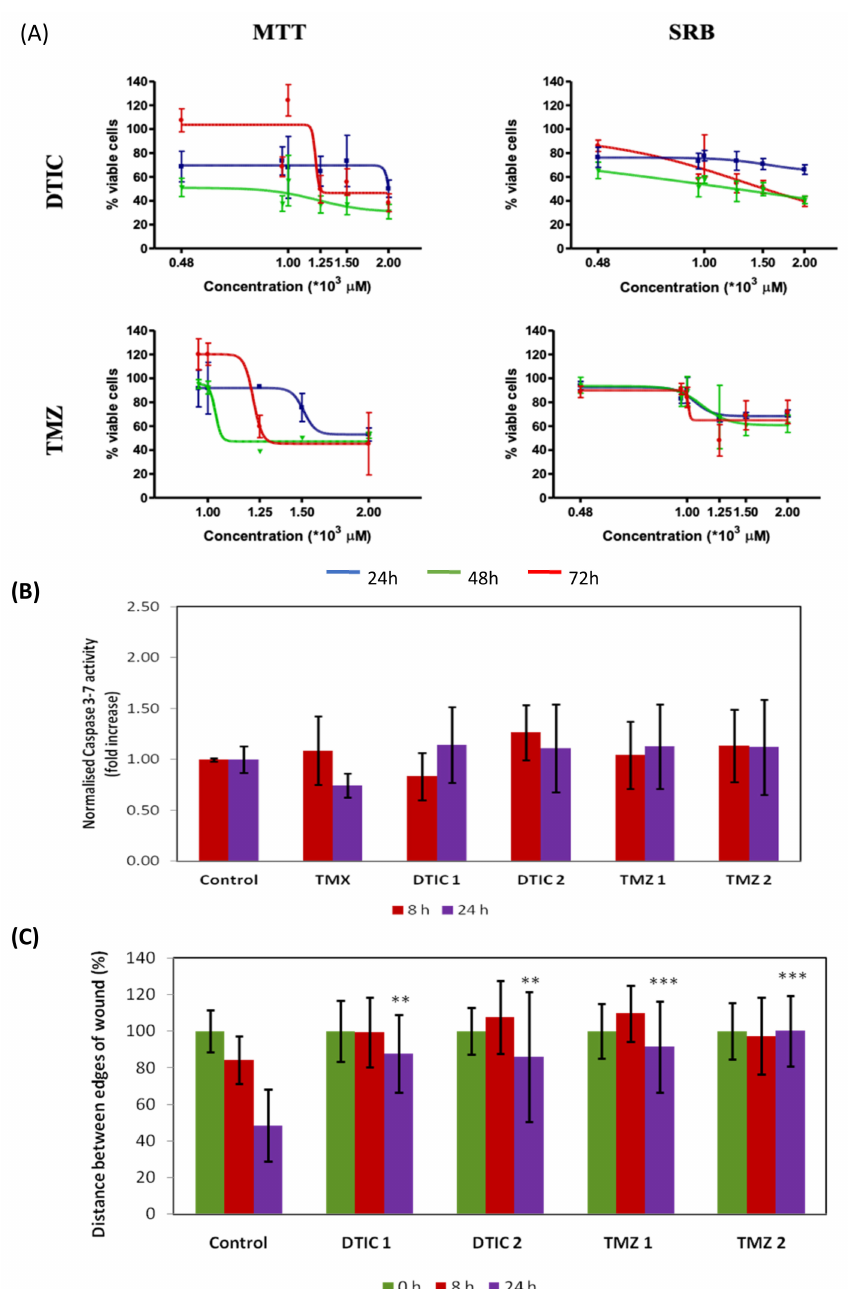
Figure 3. Effects of chemotherapy drugs in B16F10 cells. ( A ) Mitochondrial viability (MTT) and antiproliferative (SRB). ( B ) Caspase 3/7 activity (Y axis shows the increase in Caspase 3-7 activity relative to the control, the luminescent signal was normalised to the number of cells. ( C ) Antimigra- tory effect in a scratch test. DTIC1 and TMZ1 denote cells incubated with IC 20 . DTIC2 and TMZ2 denote cells incubated with IC 50 . All quantitative values are the mean of three independent assays run in duplicate. Error bars represent SD. Statistical significance by two-tailed unpaired t -test with 95% confidence interval (*** p < 0.001 ** p <